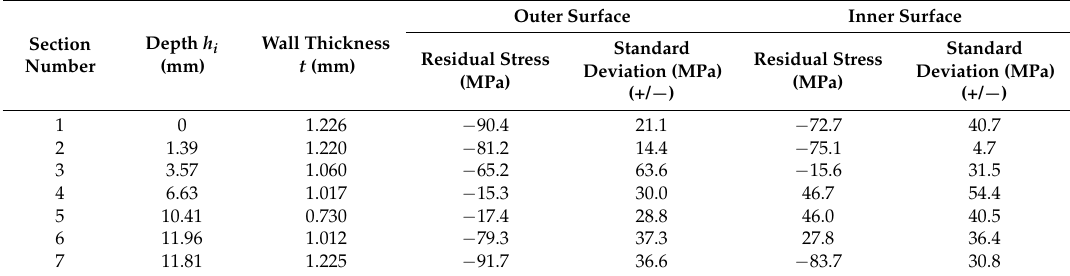
Figure 5. Measured residual stress values on ( a ) the inner surface, ( b ) the outer surface, and ( c ) schematic representation of the residual stress value curves and their standard deviation error bars attained during the XRD measurements as a function of the SPIF process forming depth, h i , and the wall angle α parameter values. Table 1. Residual stress values recorded in the inner and outer surfaces of the AM Aluminum sheets as a function of the forming